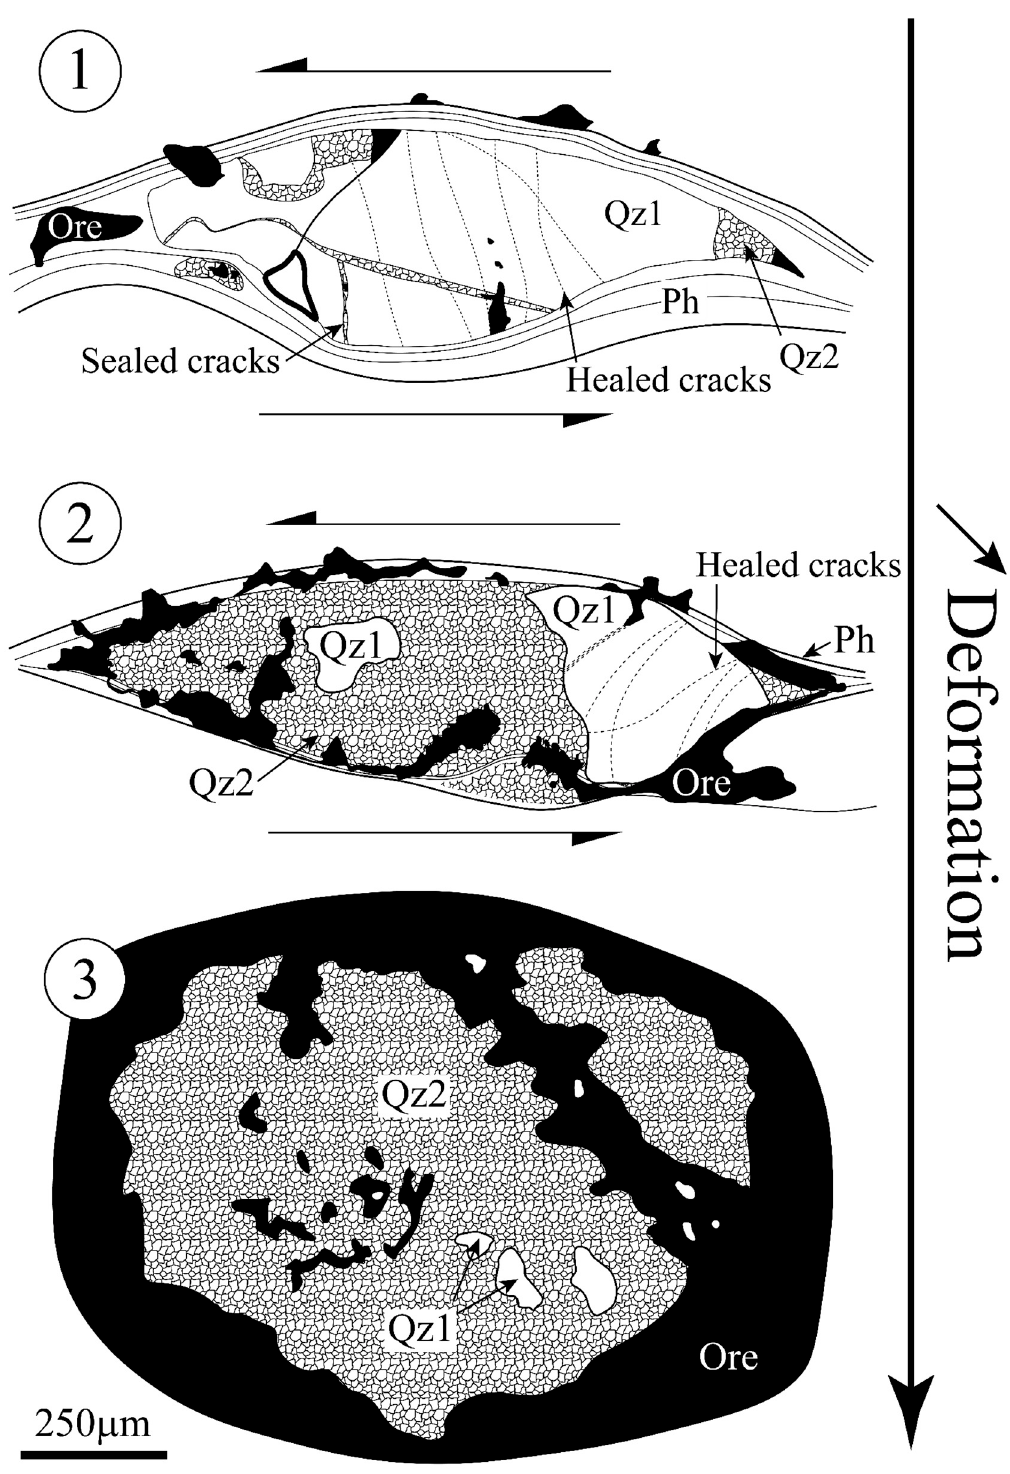
Figure 12. Scheme of quartz porphyroclast (Qz1) and textural evolution of the ore in mylonites due to increasing deformation (Step 1 to 3) and fluid circulation: from disseminated ore (step 1 and 2) to massive ore (step 3).